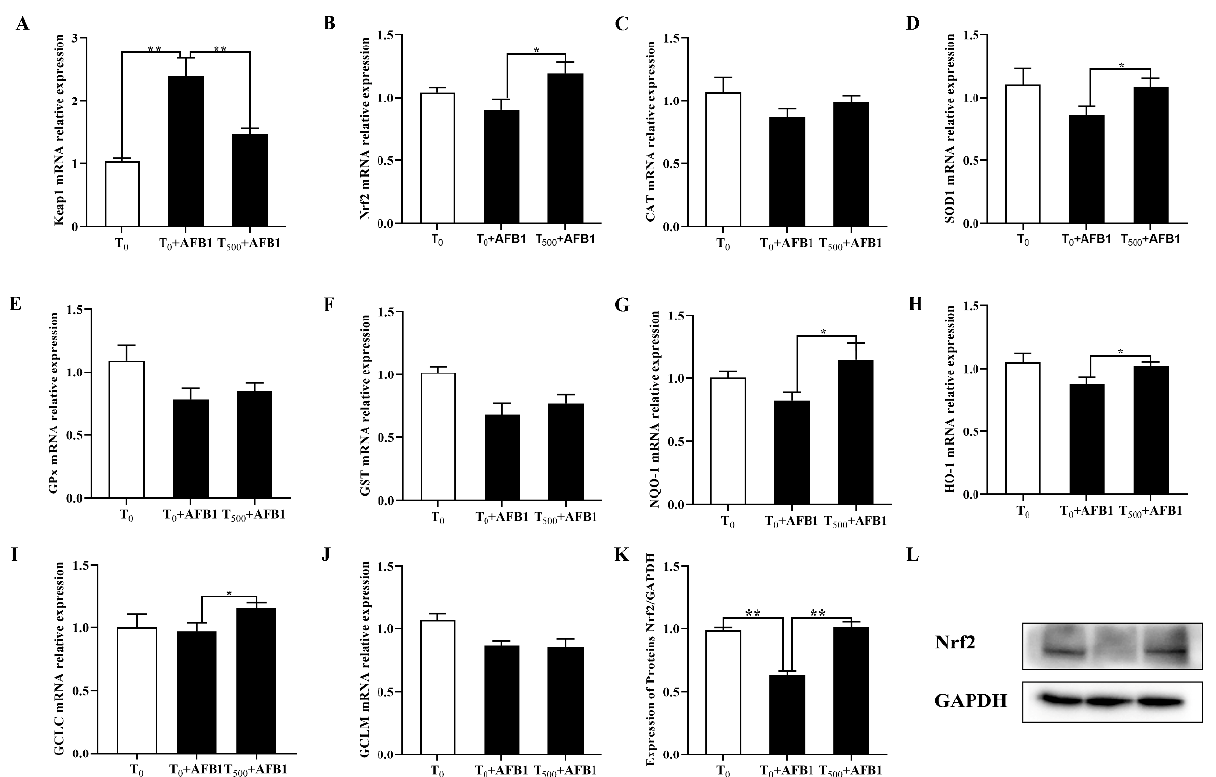
Figure 4. mRNA and protein expression of genes related to Nrf2-ARE signaling pathway in the ileum of ducks ( Anas PlatyrhynchosI ) exposed to AFB1 at 70 days. T 0 : the control group, T 0 + AFB1: AFB1 group; T 500 + AFB1: curcumin + AFB1 group. Keap1, Kelch-like ECH-associated protein ( A ); Nrf2, Nuclear factor erythroid 2-related factor 2 ( B ); CAT, Catalase ( C ); SOD, Superoxide dismutase ( D ); GPx, Glutathione peroxidase (E); GST, Glutathione S-transferase ( F ); NQO1, NAD(P)H quinone oxidoreductase 1 ( G ); HO-1, Heme oxygenase 1 ( H ); GCLC, Glutamate cysteine ligase catalyzes subunits ( I ); GCLM, Glutamic acid cysteine ligase modified subunit ( G ); GAPDH, Glyceraldehyde-3-phosphate dehydrogenase ( K ). Genes including the enzymatic antioxidant system (CAT, SOD1, GPX and GST) and phase II detoxification enzymes (NQO-1, HO-1, GCLC and GCLM). The relative expression of Nrf2 protein in the ileum were expressed as the ratio of band intensity of the target protein to internal reference (GAPDH) ( K , L ). Values were expressed as Mean ± SEM ( n = 15), and * means p < 0.05, ** means p < 0.01.